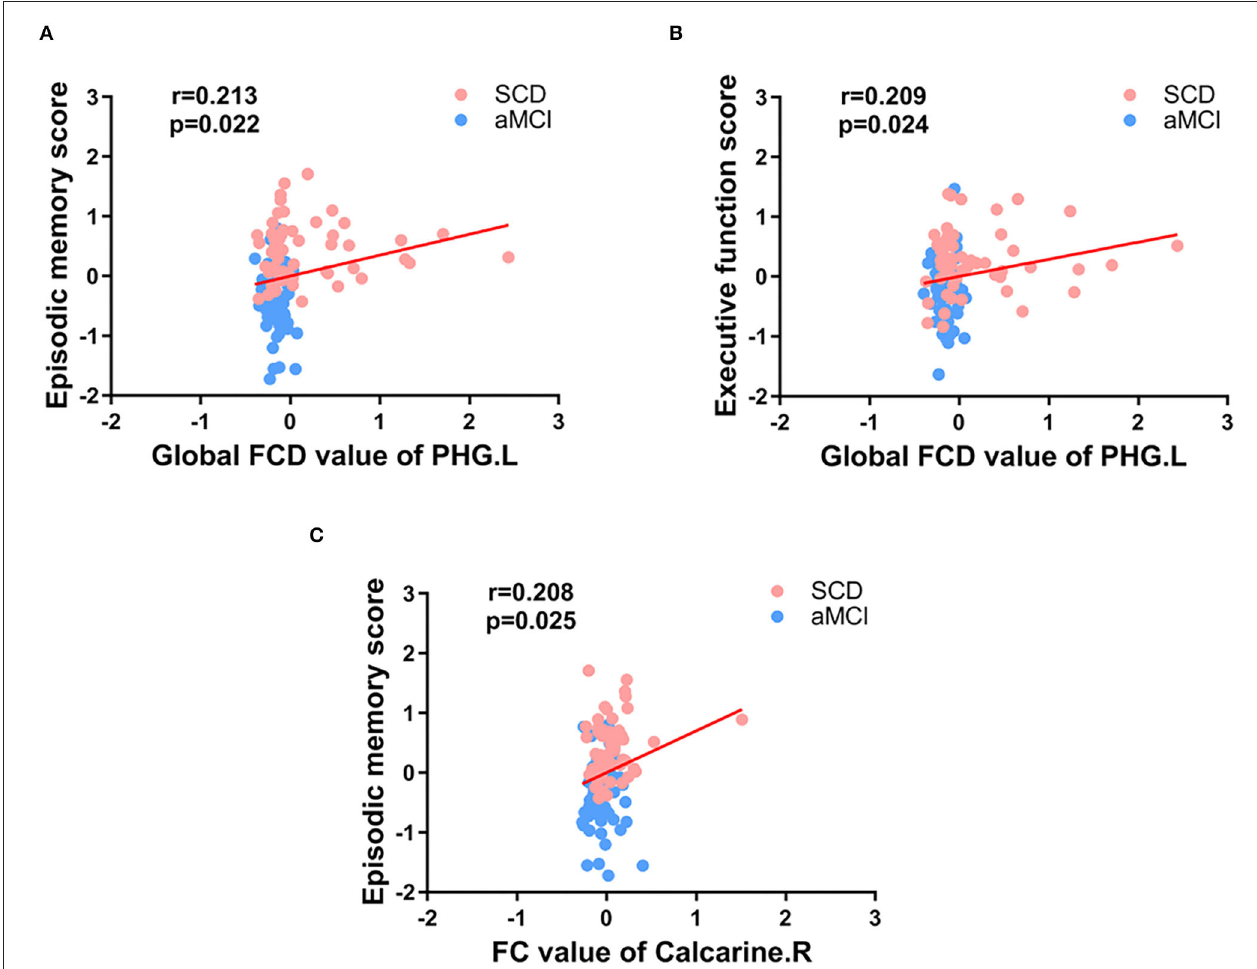
FIGURE 5 | Significant associations between the FCD value or FC value in abnormal brain regions and cognitive function (A-C) . Age, gender, and education level were used as covariates (Bonferroni corrected, p < 0.05). SCD, subjective cognitive decline; aMCI, amnestic mild cognitive impairment; FC, functional connectivity; FCD, functional connectivity density; PHG, parahippocampal gyrus; L, left; R, right.